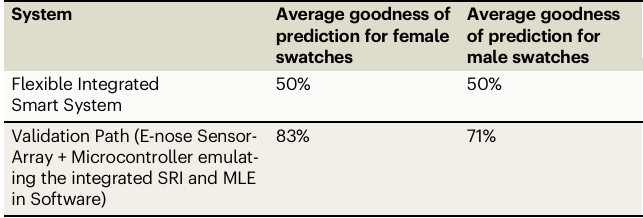
Table 2 | The performance results of the two system prototypes